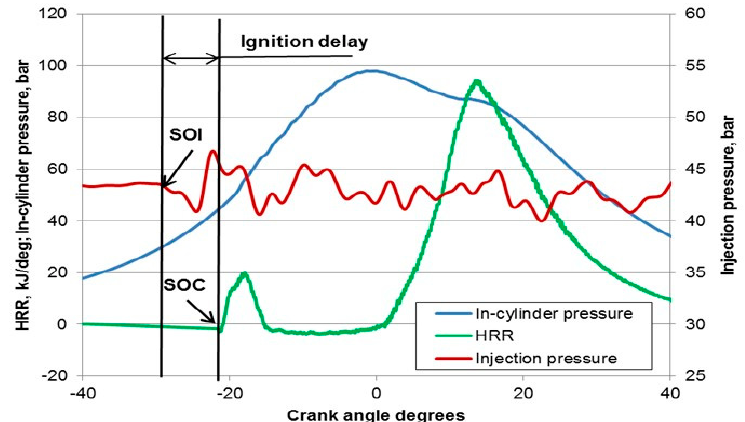
Figure 2. Definition of the ignition delay for a pilot fuel portion: as period in crank angle degrees (CADs) between the start of injection (SOI) and the start of combustion (SOC).